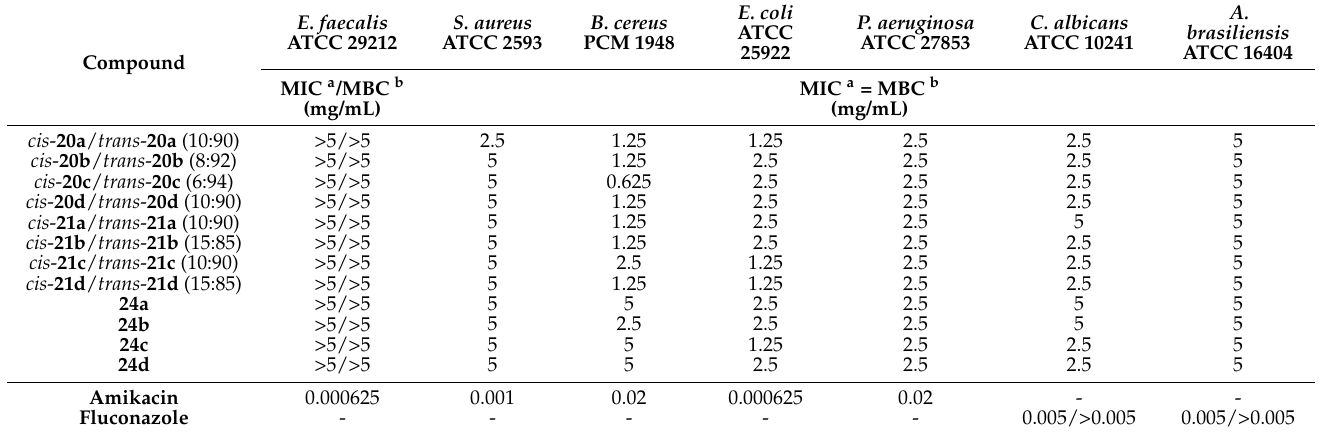
Table 3. Antimicrobial activity of isoxazolidines cis - 20 / trans - 20 and cis - 2a / trans - 2a , and alkene 24